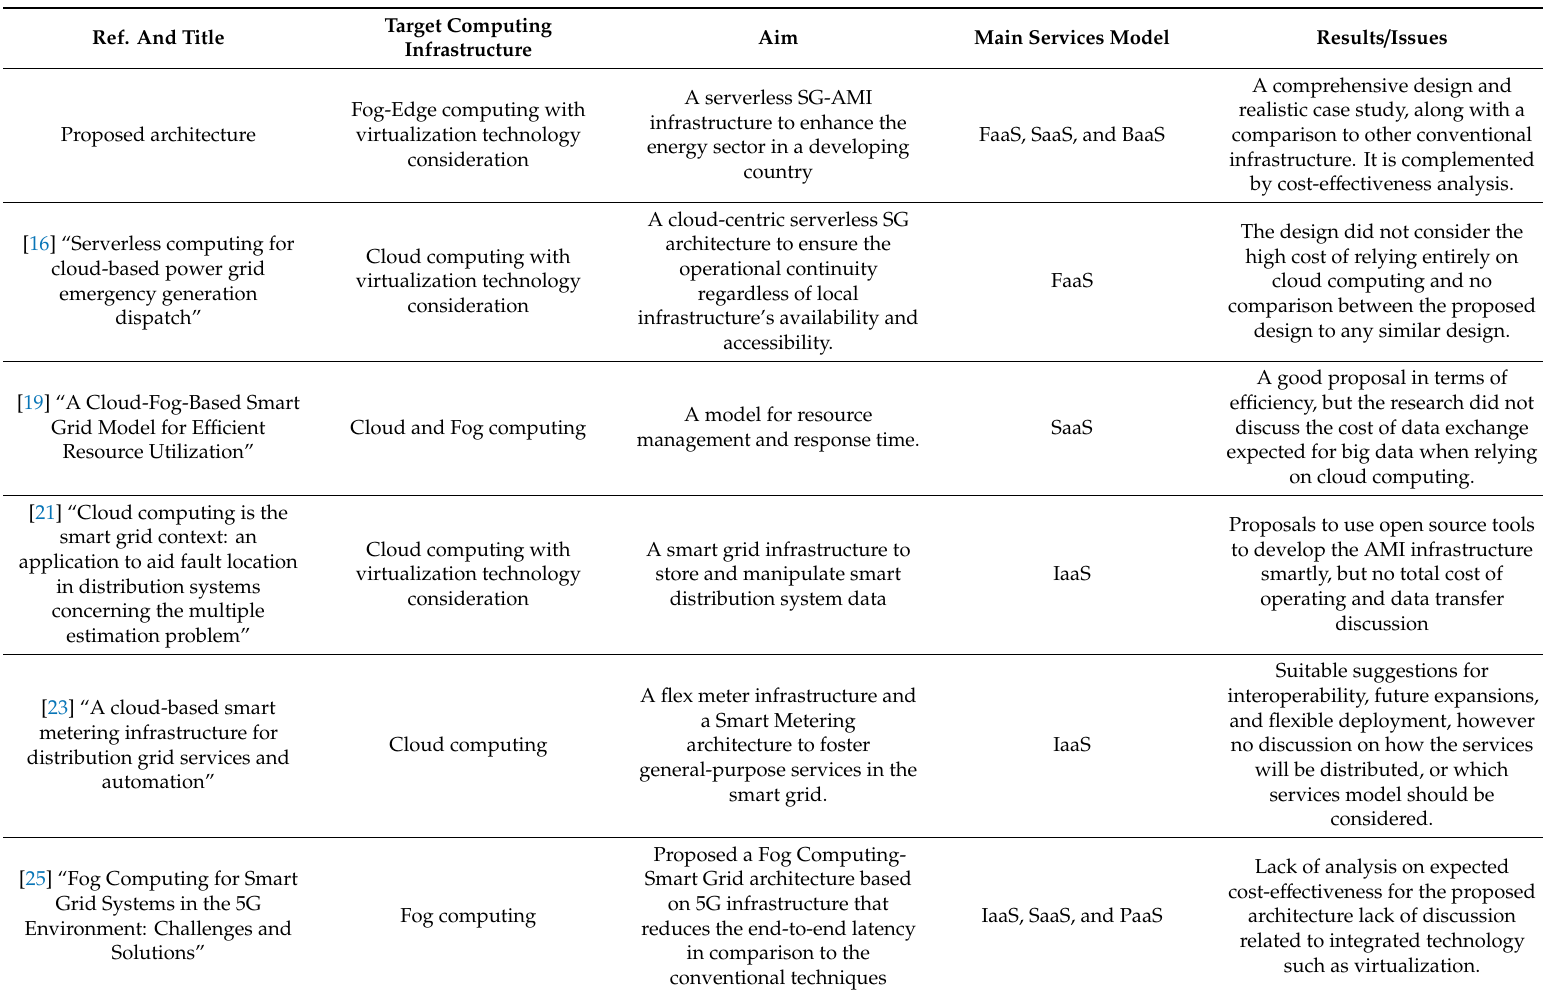
Table 1. Summary of the recent works on SG computing